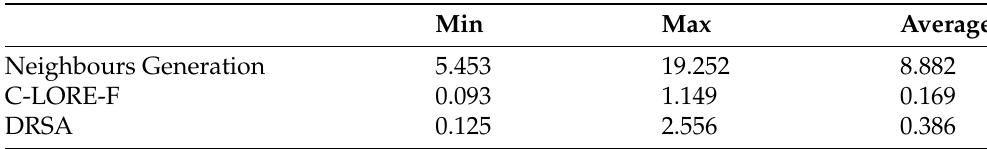
Table 3. Running time